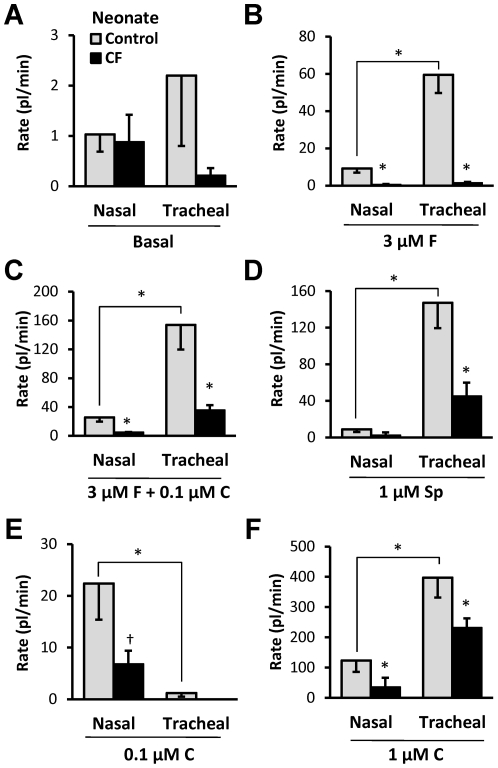
Summary of secretory responses comparing control vs. CF and nasal vs. tracheal glands in neonatal piglets.Data for tracheal responses taken from Joo et al., [38]. A–F, Each graph shows control (open bars) and CF (closed bars) secretory rates for nasal (left) or tracheal (right) glands in response to the agents shown. * indicates t-test P<0.05 for either WT vs. CF or nasal vs. tracheal. † indicates Mann-Whitney test P<0.02. See text.